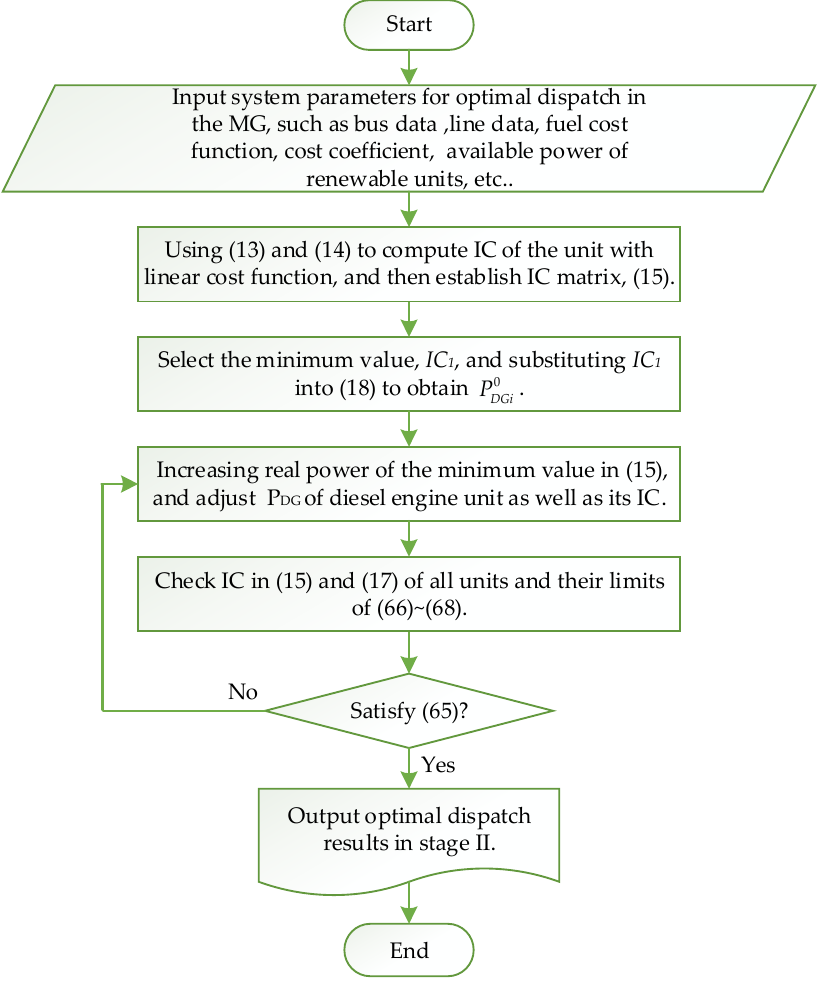
Figure 3. Solution flow chart of IDSM in an MG.